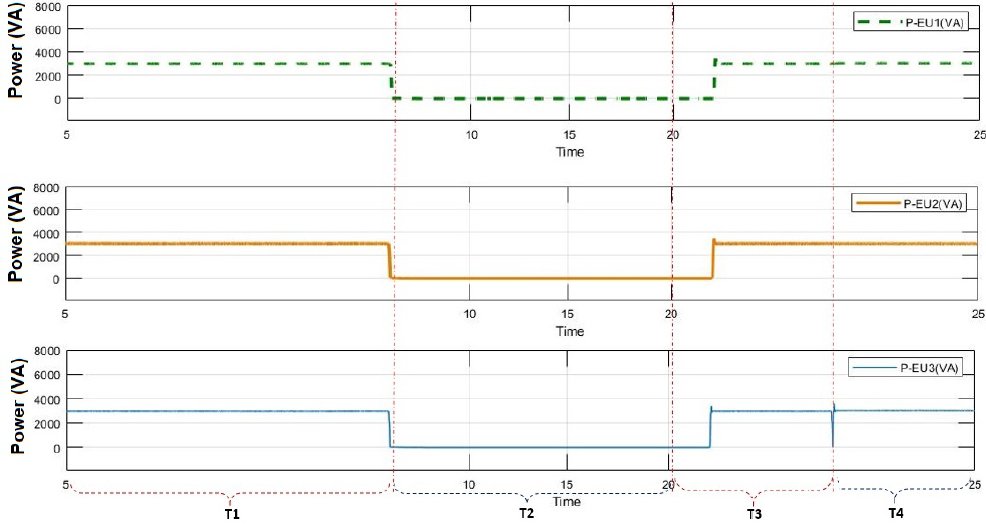
Figure 12. Voltage and Apparent Power graphs (Three-Phases signals) measured at the secondary output of the Distribution